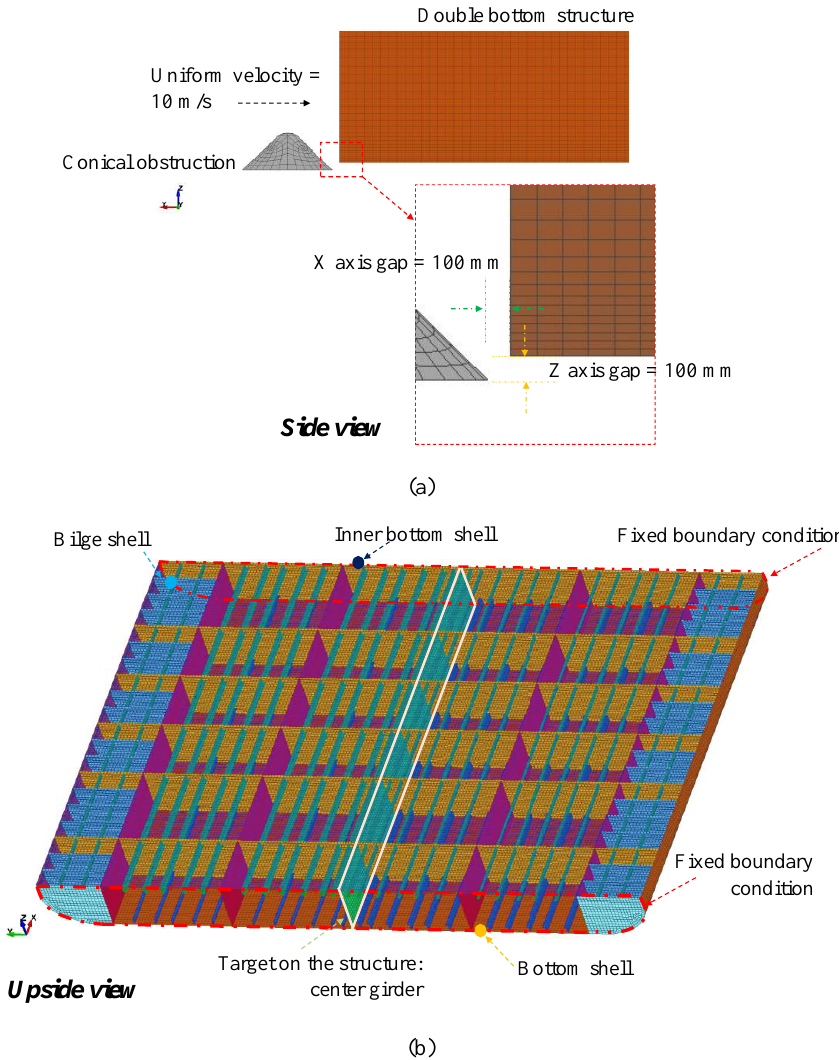
Figure 7. Grounding scenario adopted from the raking case: (a) gap configuration of two entities and (b) location of the applied boundary condition and target member on the double bottom structure.